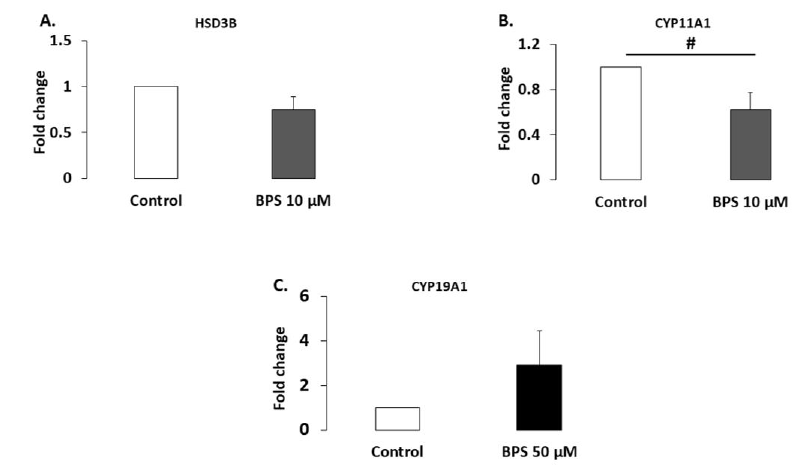
Figure 5. E ff ect of Bisphenol S (BPS) on steroidogenic enzyme expression. HGC underwent 48-h culture in the presence or absence of BPS (10 nM, 100 nM, 1 µ M, 10 µ M or 50 µ M). Proteins were then extracted and separated using electrophoresis on 4–12% ( w / v ) sodium dodecyl sulphate polyacrylamide CYP11A1 ( B ), CYP19A1 ( C ) and VCL antibodies. Bands on the blots were quantified, and the